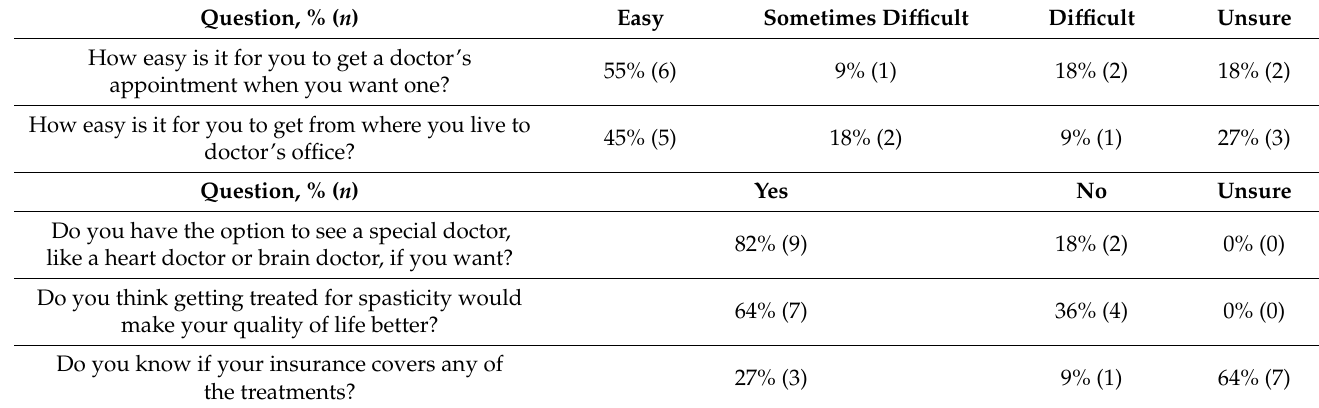
Table 2. Potential barriers to spasticity treatment for long-term care